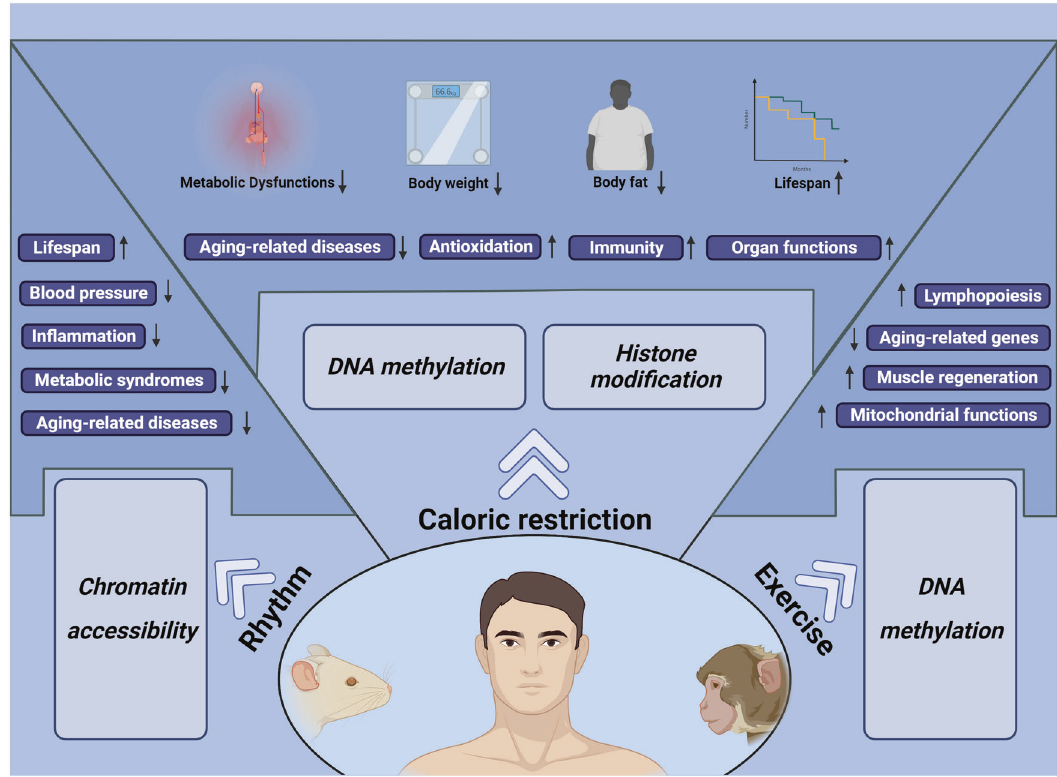
Fig. 9 A healthy lifestyle to postpone aging. Active health, including caloric restriction, rhythm control and exercise, improves body function and affects the lifespan of various animals, suggesting that healthy lifestyles exert profound effects on aging